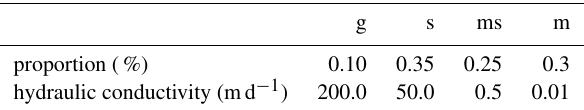
Figure 1. Illustration of the methodology used in the study, considering a representative quadrilateral subsystem of a highly heterogeneous alluvial aquifer system, 19 . 2 × 6 × 0 . 25km 3 (12 miles × 3 . 75 miles × 820 feet). A land-use map is randomly generated (a) . Each color represents a different crop. A soil map (b) is extracted from the top layer of each geostatistical realization of the hydraulic conductivity ( K ). For each combination soil-type– crop, effective leakage rates of water and nitrate are numerically estimated. White particles represent a snapshot of the NPS pollu- tion (particles) 80 years after a single year of contaminant loading. In each simulation, three extraction wells are explicitly represented at the downstream location of the domain. The lower part of each well (in red) represents its screen from where water is extracted and from where mass arrival is recorded. Other wells are implicitly represented by the flux into the lower boundary of the domain. Table 1. Proportion and hydraulic conductivity of the four cate- gories (g: gravel; s: sand; ms: muddy sand; m: mud).